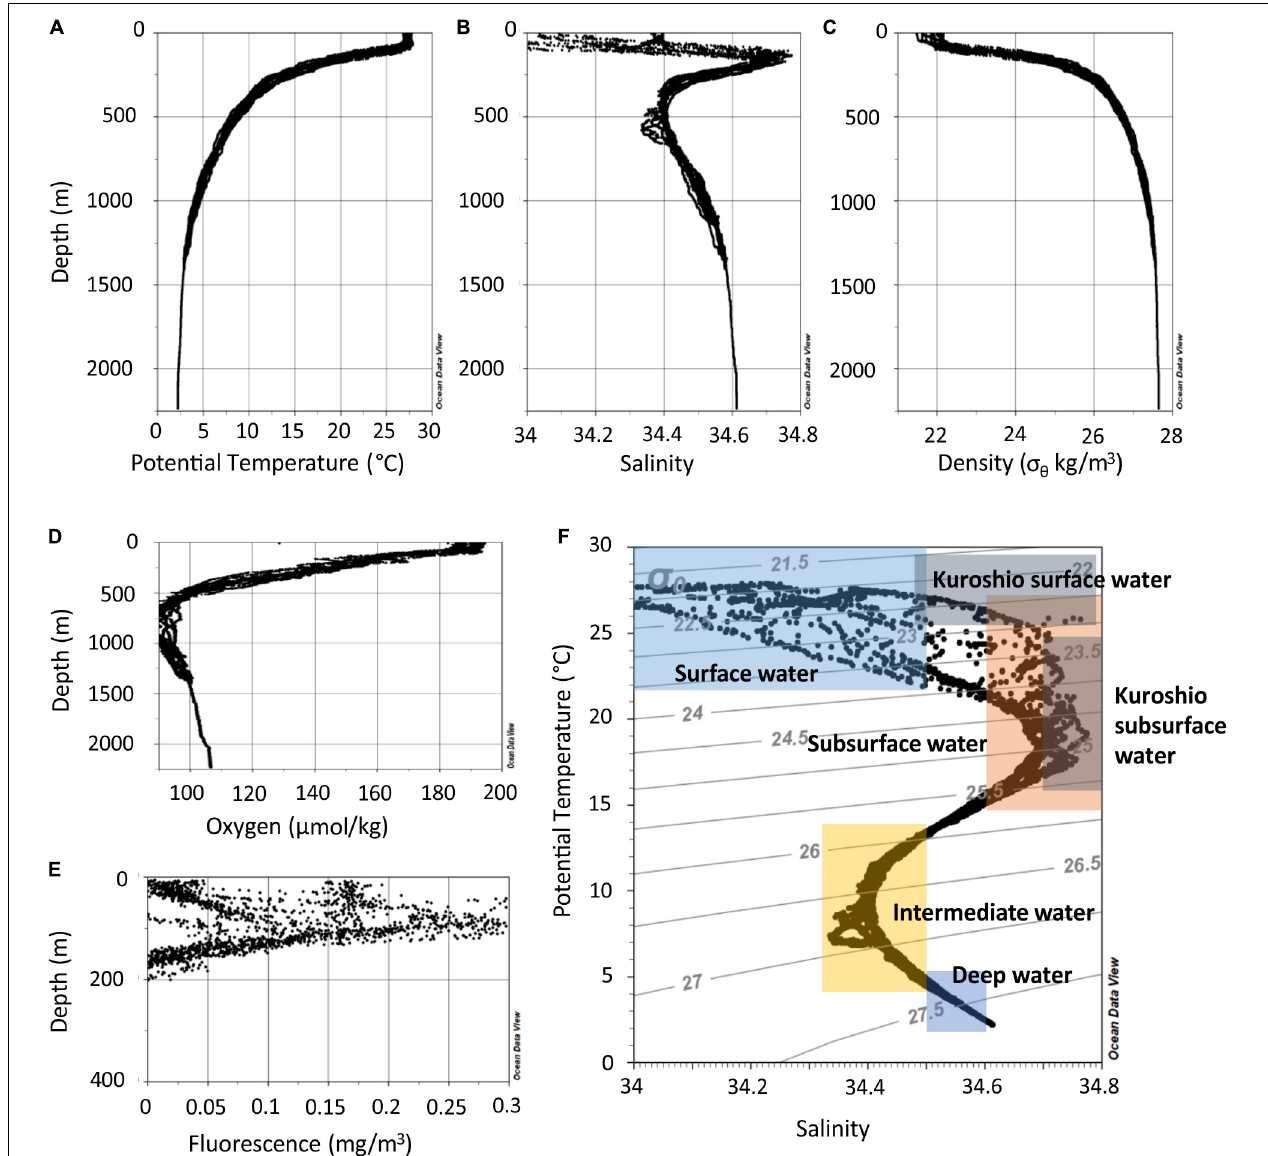
FIGURE 2 | Depth profiles of all measurements of potential temperature (A) , salinity (B) , potential density ( σ θ ) derived from potential temperature and in situ salinity (C) , oxygen concentration (D) , and fluorescence (E) . (F) Potential temperature versus salinity data of all stations. The colored rectangles indicate potential temperatures and salinities of local water masses as described in Hu et al.